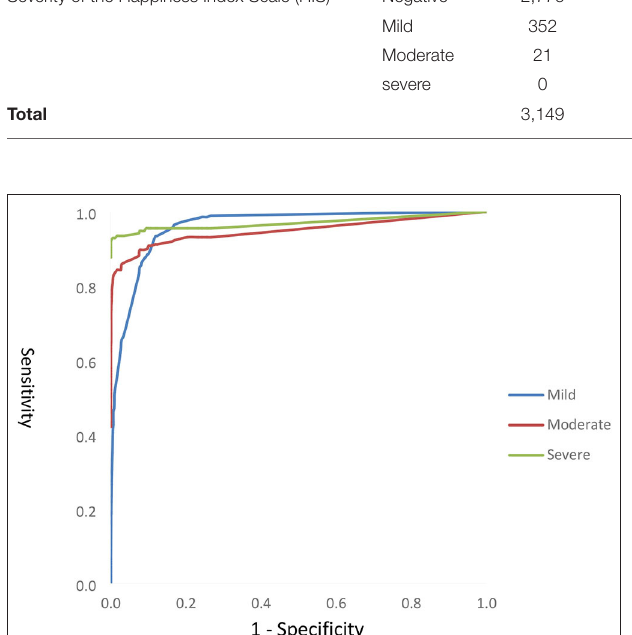
FIGURE 1 | ROC curve